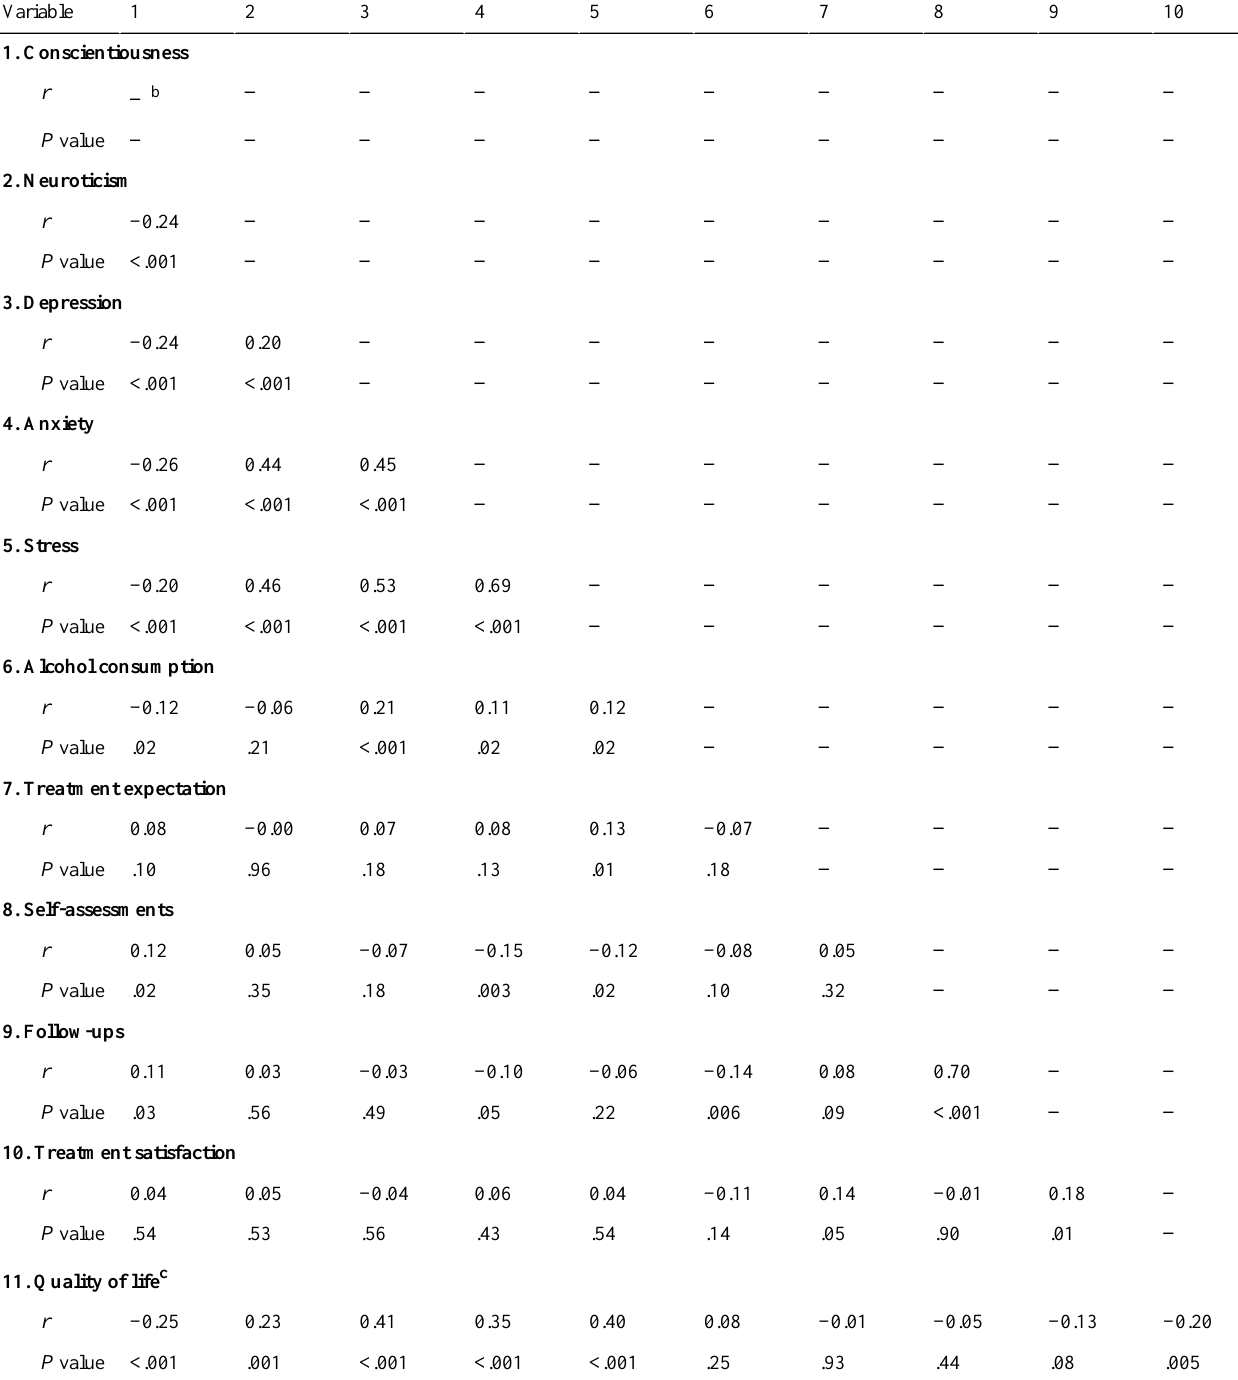
Table 2. Pearson correlations between key variables a